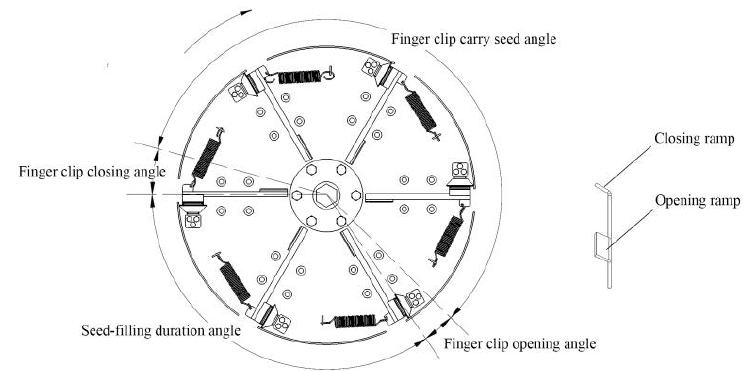
Figure 4. Seeding control mechanism movement phase.